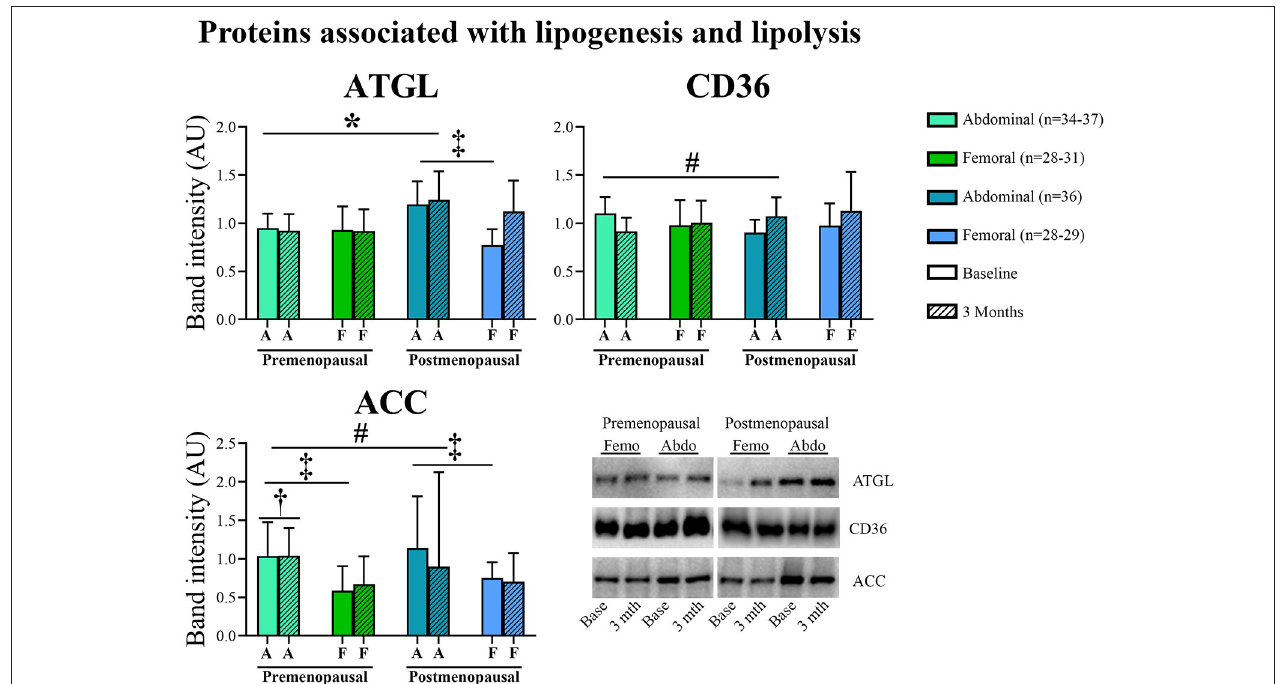
FIGURE 5 | Abundance of proteins associated with lipogenesis and lipolysis in abdominal and femoral subcutaneous adipose tissue in pre- and post-menopausal woman before and after 3 months of high-intensity training. Abdominal ATGL content was higher in post- compared to pre-menopausal women. ATGL content was higher in abdominal compared to femoral adipose tissue in the post-menopausal women. Abdominal CD36 content decreased after exercise training in pre- but increased in post-menopausal women. Abdominal ACC content increased after exercise training in pre- and decreased in post-menopausal women. Pre-menopausal women increased abdominal ACC content after the training intervention. ACC content was higher in abdominal compared to femoral adipose tissue. Interaction between groups and time # p ≤ 0.05. Changes from baseline to 3 months † p ≤ 0.05. Difference between abdominal and femoral depots ‡ p ≤ 0.05. Difference between groups * p ≤ 0.05. ATGL and CD36 protein abundances are presented as mean (95% confidence limits). ACC protein abundance is presented as median (25–75 percentile). ATGL, Adipose triglyceride lipase; CD36, Cluster of differentiation 36; ACC, Acetyl-CoA carboxylase.